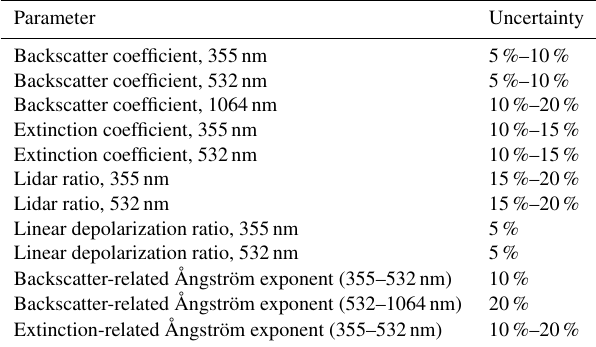
Table 1. Particle optical properties observed with lidar during the CADEX campaign and typical values for the relative uncertainties in the presented layer mean